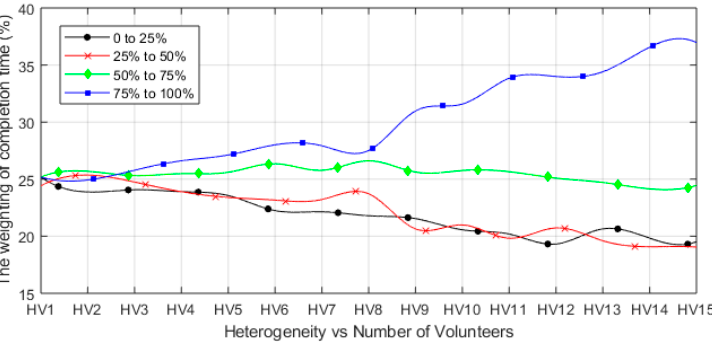
Figure 7. The weighting of the time to complete a 25% workload vs. evaluation pairs.